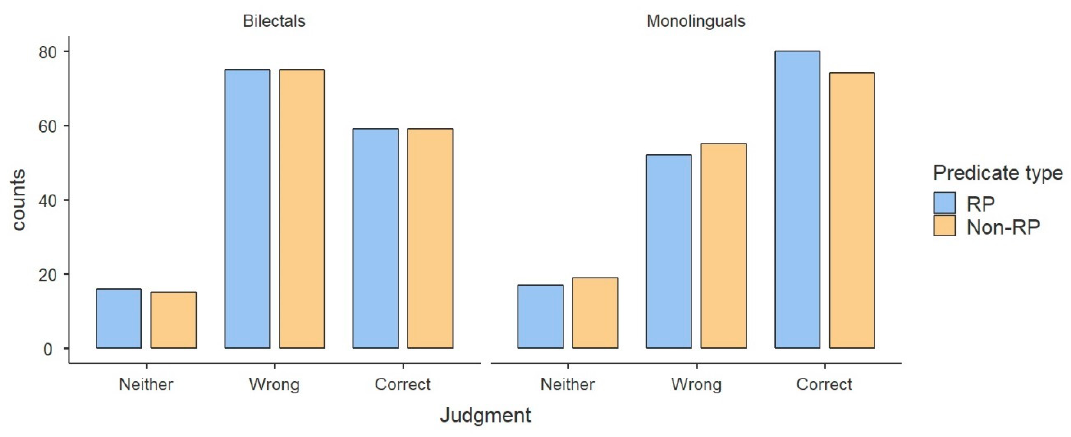
Figure 5. Acceptability judgments split for language group and type of predicate. RP = repeatable.